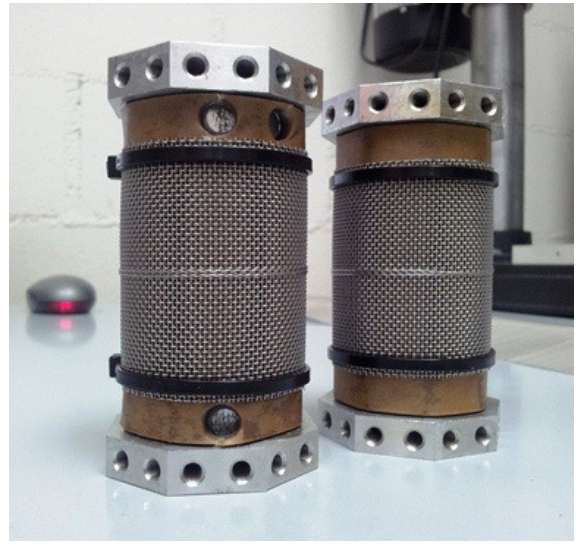
Figure 2. Two prototypes with impregnated paper and metallic mesh belts. The left specimen has three holes where samples have been take to be analyzed with the Karl Fischer